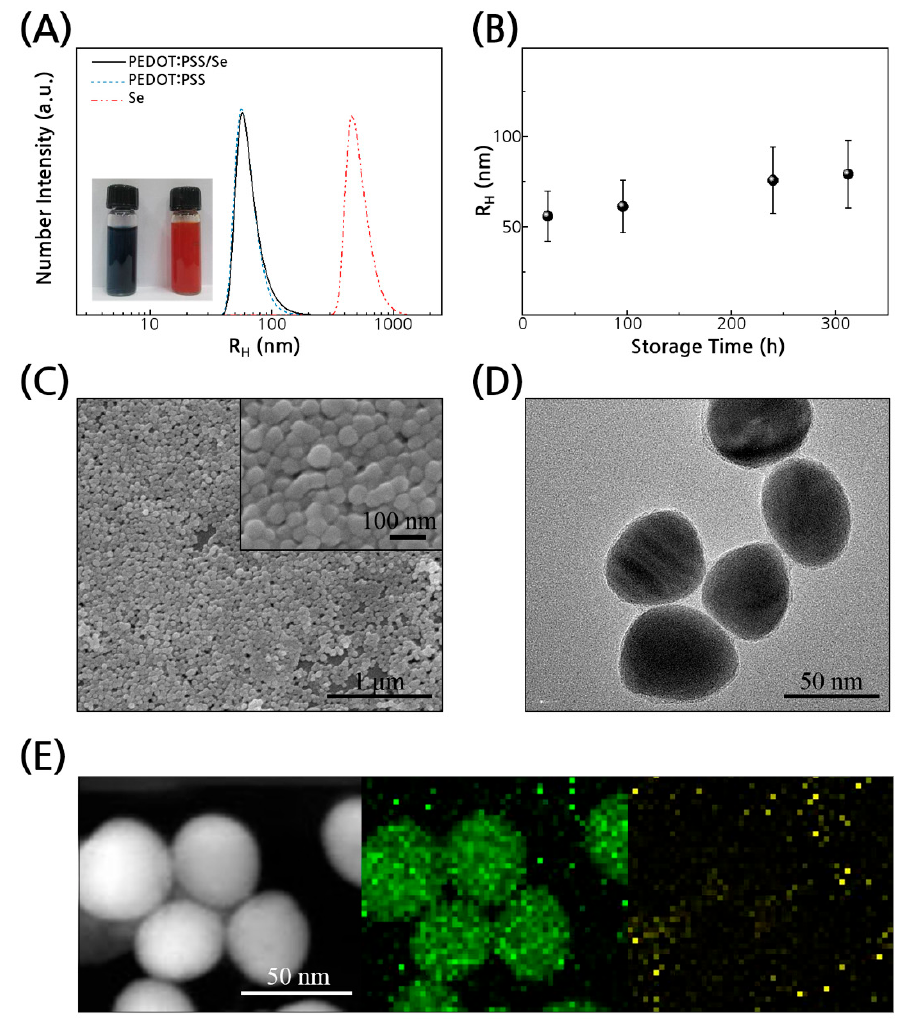
Figure 2. Structure of PEDOT:PSS / Se nanoparticles. ( A ) Dynamic light scattering (DLS) traces of PEDOT:PSS / Se, PSS / Se, and Se particles. a.u., arbitrary unit. Inset: photograph of aqueous solution of PEDOT:PSS (left) and PEDOT:PSS / Se nanoparticles (right). ( B ) The hydrodynamic radius (R H ) of PEDOT:PSS / Se particles monitored for two weeks. ( C ) Scanning electron microscopy (SEM) and ( D ) Transmission electron microscopy (TEM) images of the composite particles. ( E ) High-angle annular dark-field scanning TEM (HAADF-STEM) image (left) and energy dispersive X-ray spectroscopy (EDS) mapping of Se (middle) and sulfur (right).